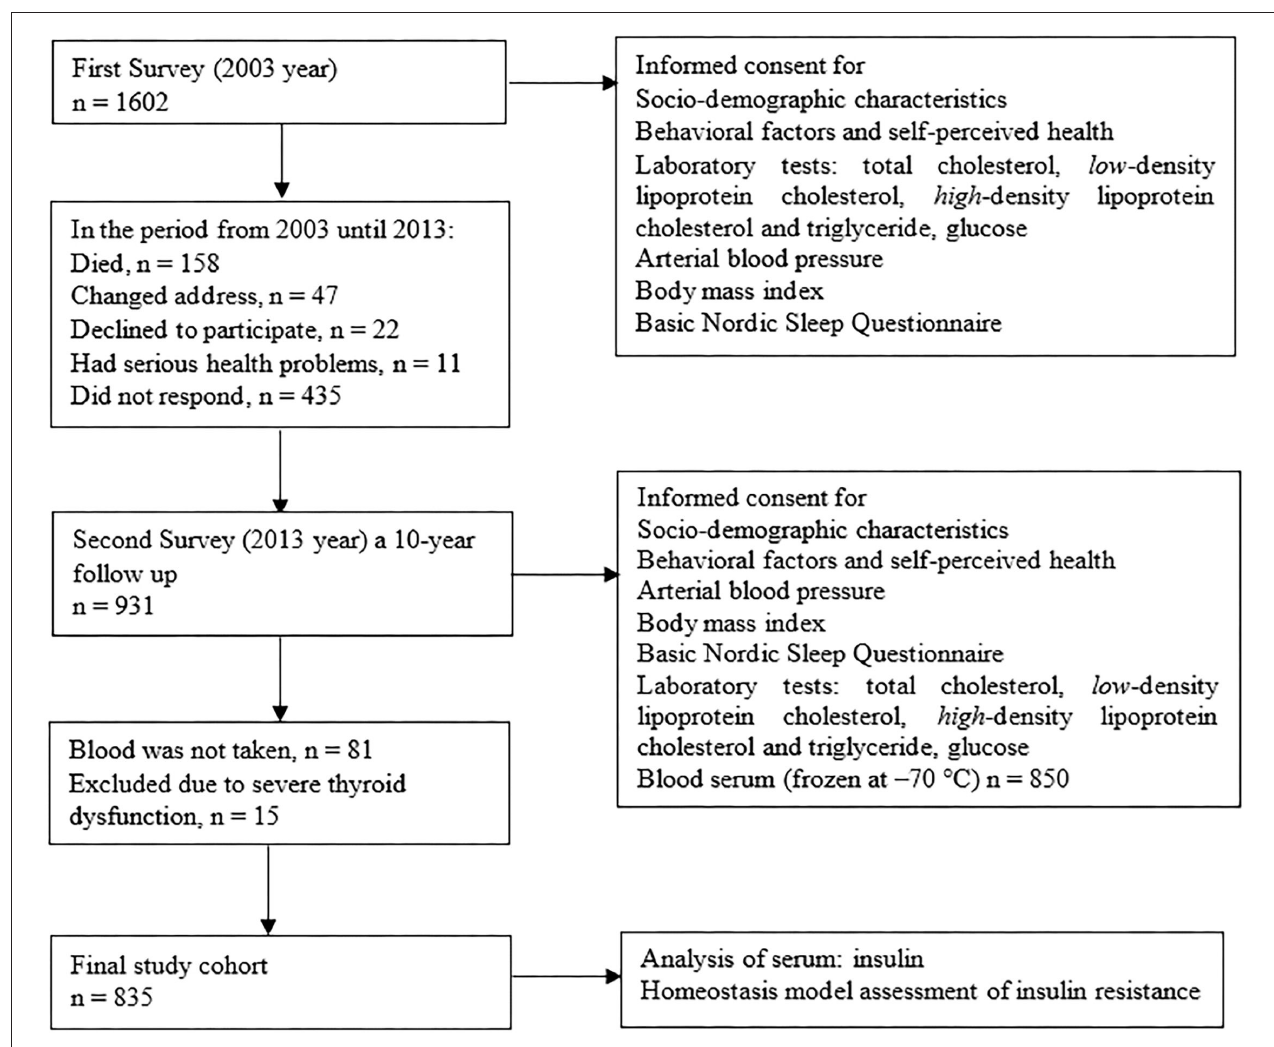
FIGURE 1 | Study flow